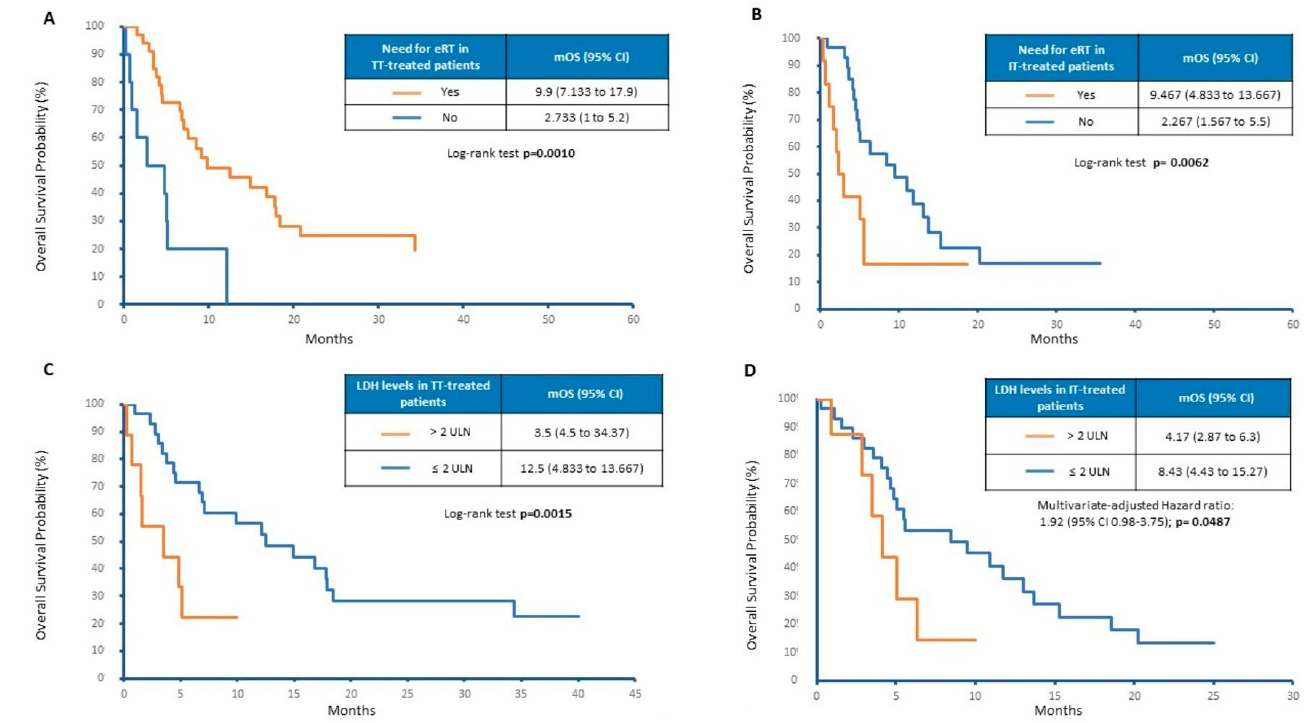
Figure 3. Overall survival by ( A ) eRT in TT-treated patients, ( B ) eRT in IT-treated patients, ( C ) LDH levels in TT-treated patients and ( D ) LDH levels in IT-treated patients.